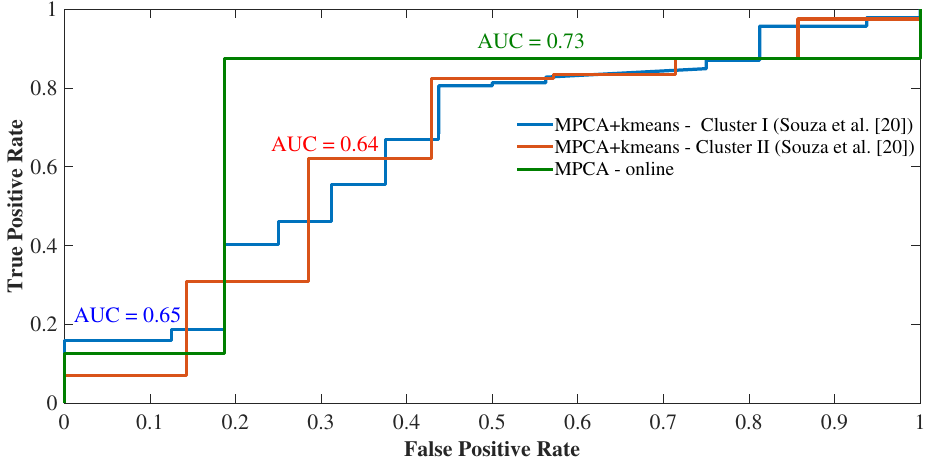
Figure 10. Detection performances of the methods MPCA offline × MPCA